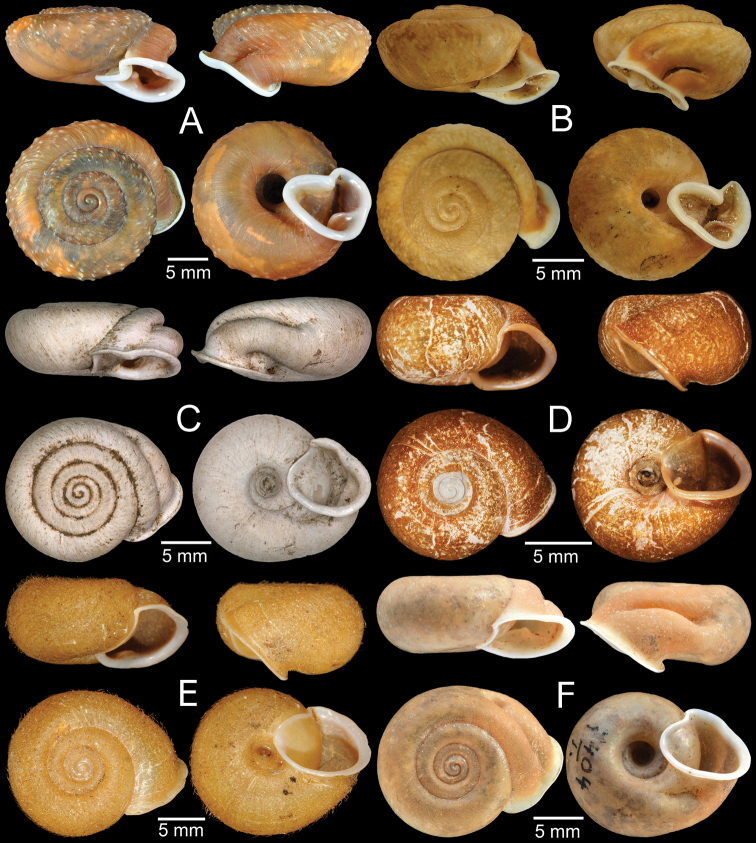
AMoellendorffia
spurca, syntype MNHN-IM-2000-1992 BMoellendorffia
trisinuata, syntype ZMB 7620 CTrichelix
biscalpta, syntype MCZ 167125 DTrichelix
diminuta, lectotype ANSP 90049 ETrichelix
eucharista, lectotype ANSP 81221 FTrichelix
hiraseana, lectotype SMF 7404/1 of Stegodera
helleri. Photo: AJ Baldinger (C).